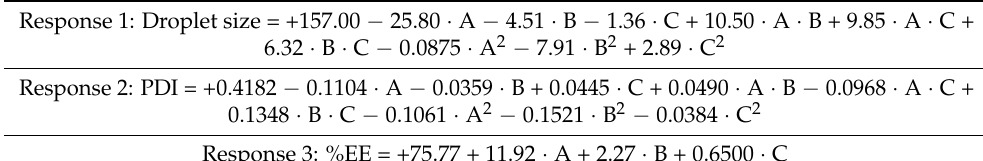
Figure 4. 3D Response surface plots representing the interaction effect for the droplet size of Que-NE ( A ) Smix and % amplitude, ( B ) Smix and sonication time, and ( C ) % amplitude and sonication time; the interaction effect for PDI of Que-NE ( D ) Smix and % amplitude, ( E ) Smix and sonication time, and ( F ) % amplitude and sonication time; and the interaction effect for %EE of Que-NE ( G ) Smix and % amplitude. Table 3. Regression equations in coded terms for all the responses of